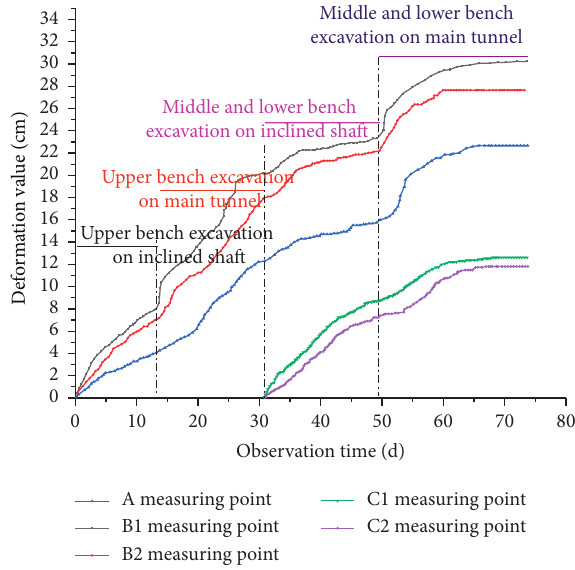
Figure 28: Deformation of Section